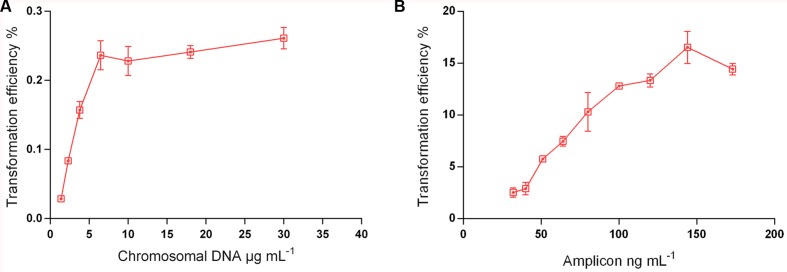
Transformation as a function of donor DNA type and concentration. S. mitis type strain pre-culture at OD600 0.5 was diluted 1:100 in C+YY B and grown until OD600 0.04 at 37°C 5% in CO2. (A) 200 μL aliquots were exposed to 300 nM of CSP and chromosomal DNA concentrations (from strain MI009) ranging from 1,38 to 30 μg mL-1. Cells were further incubated in closed tubes for 3 h at 37°C in air atmosphere. (B) 200 μL aliquots were exposed to 300 nM of CSP and 7 kb amplicon (aRJ20) concentrations varying from 32 to 173 ng mL-1. Cells were further incubated in closed tubes for 3 h at 37°C in air atmosphere. The % of CFU containing ErmR transformants was determined by plating on blood plates with and without Erm. The results are averages from 3 replicates and representative of three independent experiments. Error bars represent standard error of the mean.